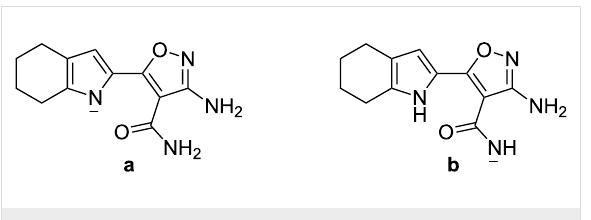
Figure 10: Anionic form a and b of receptor 1